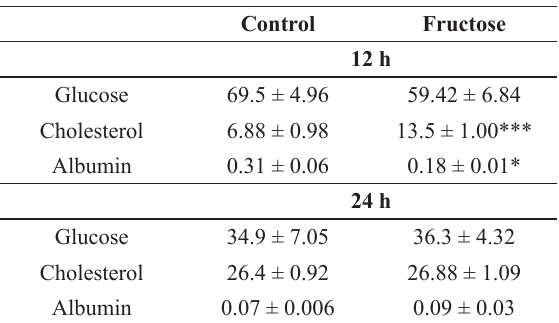
Glucose, cholesterol, and albumin levels in cerebral spinal fluid of animals submitted to an animal model of